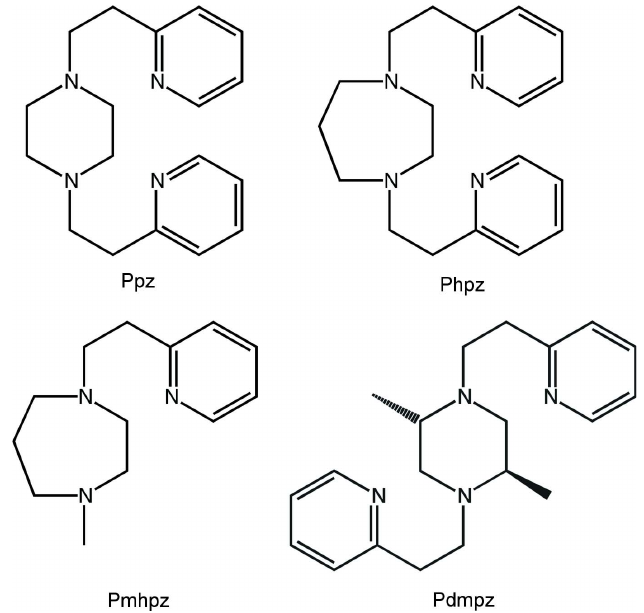
Figure 1 Ligands employed in this